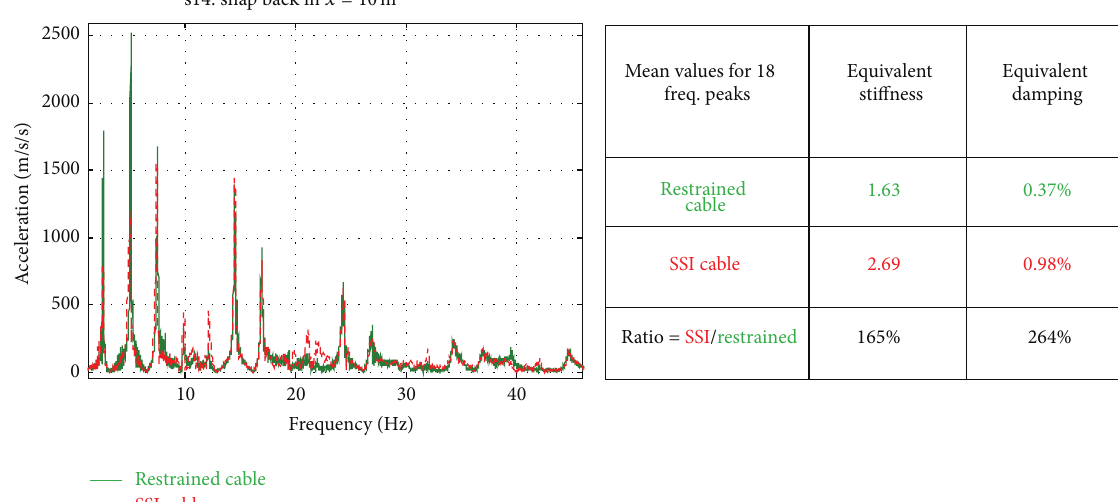
Figure 8: Equivalent stiffness and damping for the SSI cable no. 2 as compared to the restrained